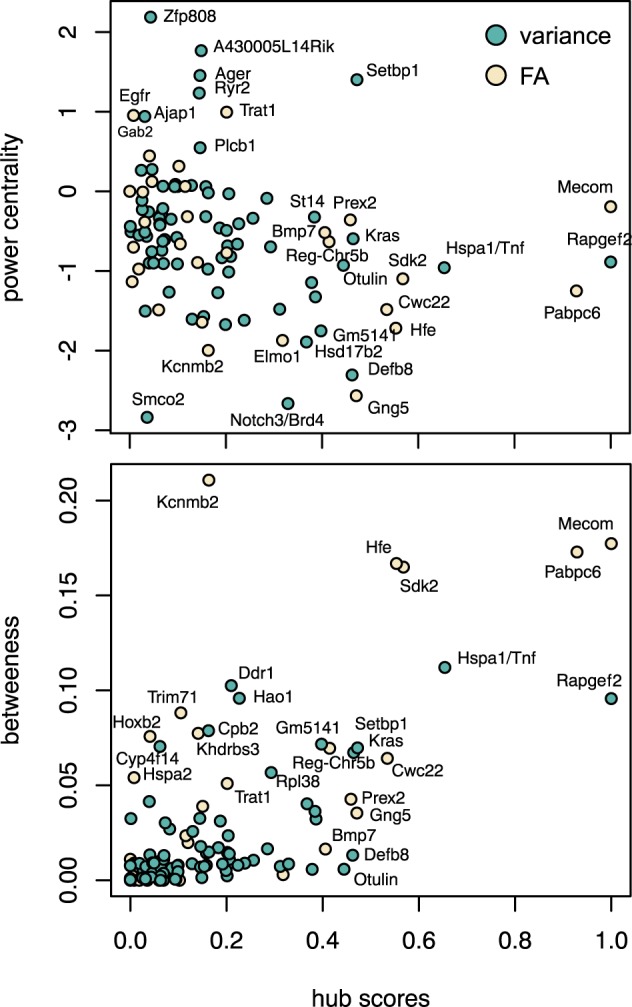
Centrality of interactive gene candidates in developmental stability and the canalization networks based on hub scores, power centrality, and betweenness.